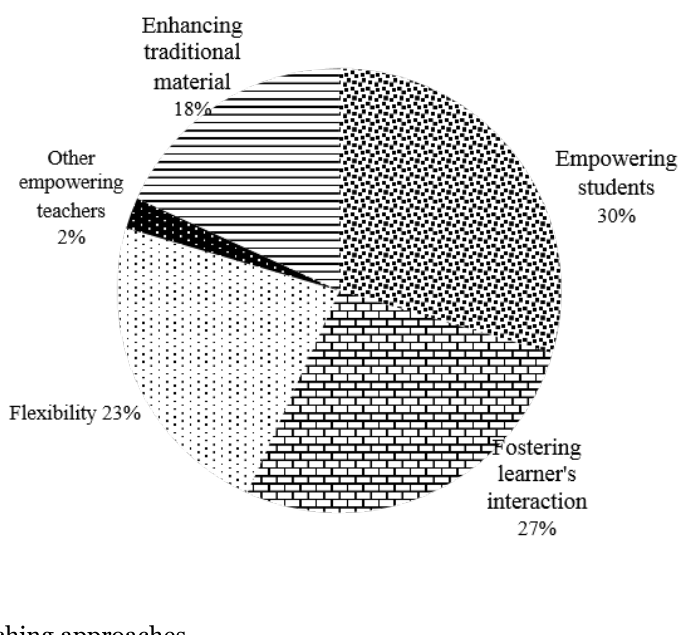
Figure 1. Effective teaching